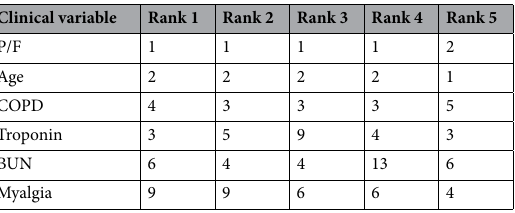
Table 1. Selected clinical variables and their corresponding rankings on the 5 patient subgroups.